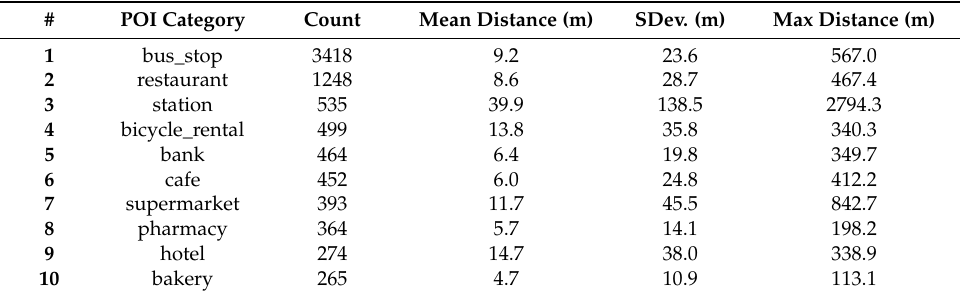
Table 1. The statistics of the positional movement of the top 10 OSM feature types according to the number of features.